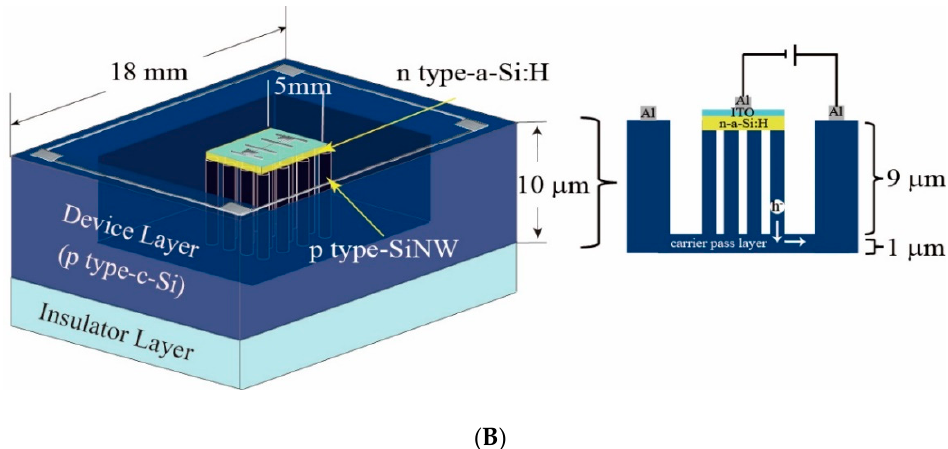
Figure 1. ( A ) Fabrication process for silicon nanowire (SiNW)-array-based solar cell on an silicon-on-insulator (SOI) substrate ( B ) Schematic of a SiNW-array-based solar cell etched on the SOI substrate.